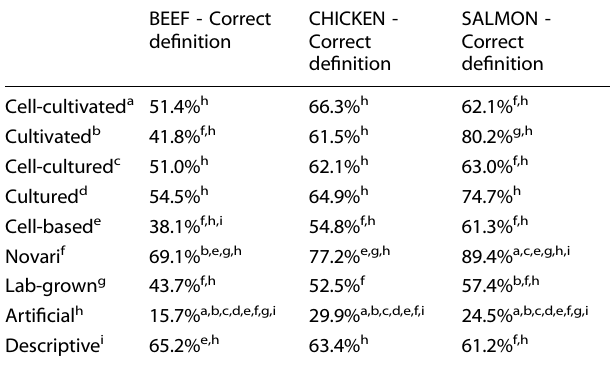
Fig. 9 Perceived allergen safety of salmon by label. The graph shows the proportion of people who correctly identi fi ed that cell-cultivated salmon products are not safe for allergy-sufferers, incorrectly identi fi ed that they are safe for allergy sufferers, and did not know. Table 6. Pairwise comparisons between names on the percentage correctly identifying products as